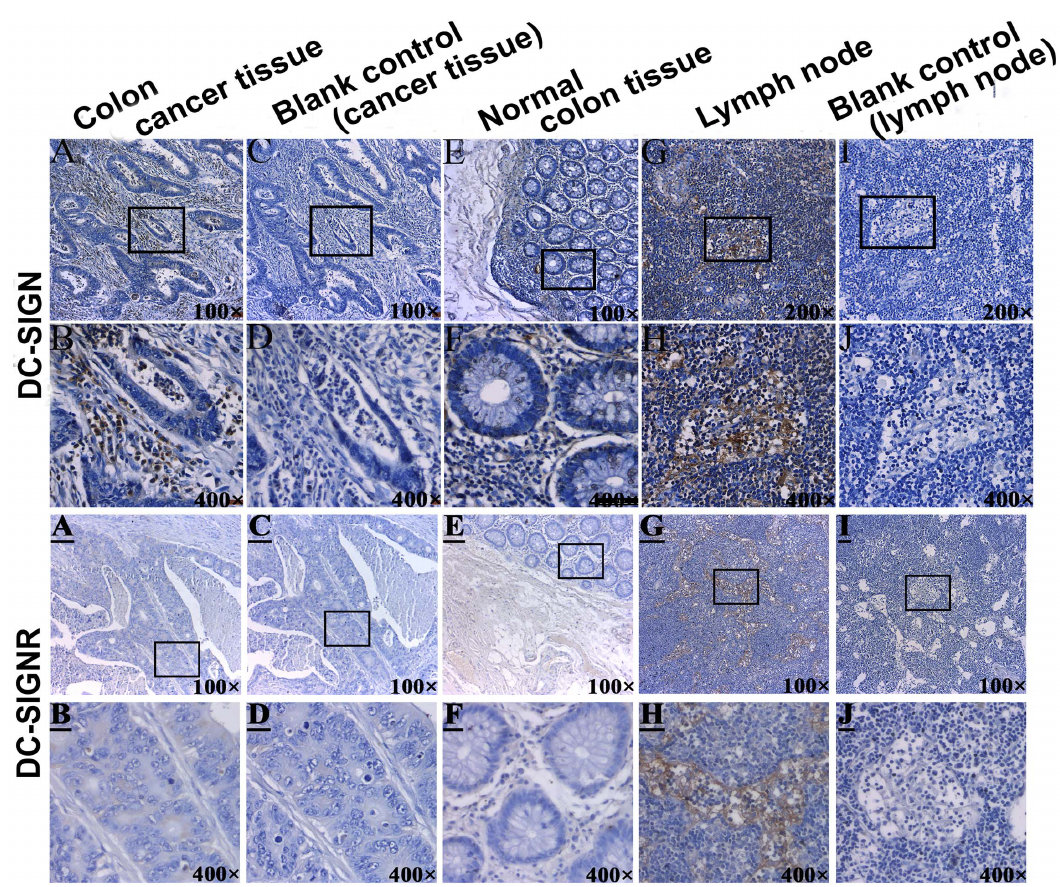
Fig. 4. IHC for DC-SIGN and DC-SIGNR expression in colon cancer tissues and in matched normal colonic mucosa of colon cancer patients. Areas in the black boxes of A , C , E , G , I and A , C , E , G , I were enlarged below. A-B : DC-SIGN expression was detected in the internal border, central and peripheral part of colon carcinoma. C–D : blank control primary human colon cancer sections (without anti-DC-SIGN pAb). E–F : DC-SIGN expression in matched normal colonic mucosa. G–H : DC-SIGN expression was mainly detected in human lymphoid sinus. I–J : blank control human lymph node sections (without anti-DC-SIGN pAb); A–B : DC-SIGNR expression was weakly detected in the invasive margin of tumor. C–D : blank control primary human colon cancer sections. E–F : DC-SIGN expression was negative in matched normal colonic mucosa, while the G and H were positive controls in the human lymph node. I–J : blank control human lymph node sections. Magnification:100 6 in A , C , E , A , C , E , G , I ; 200 6 in G , I ; 400 6 in B , D , F , H , J , B , D , F , H , J